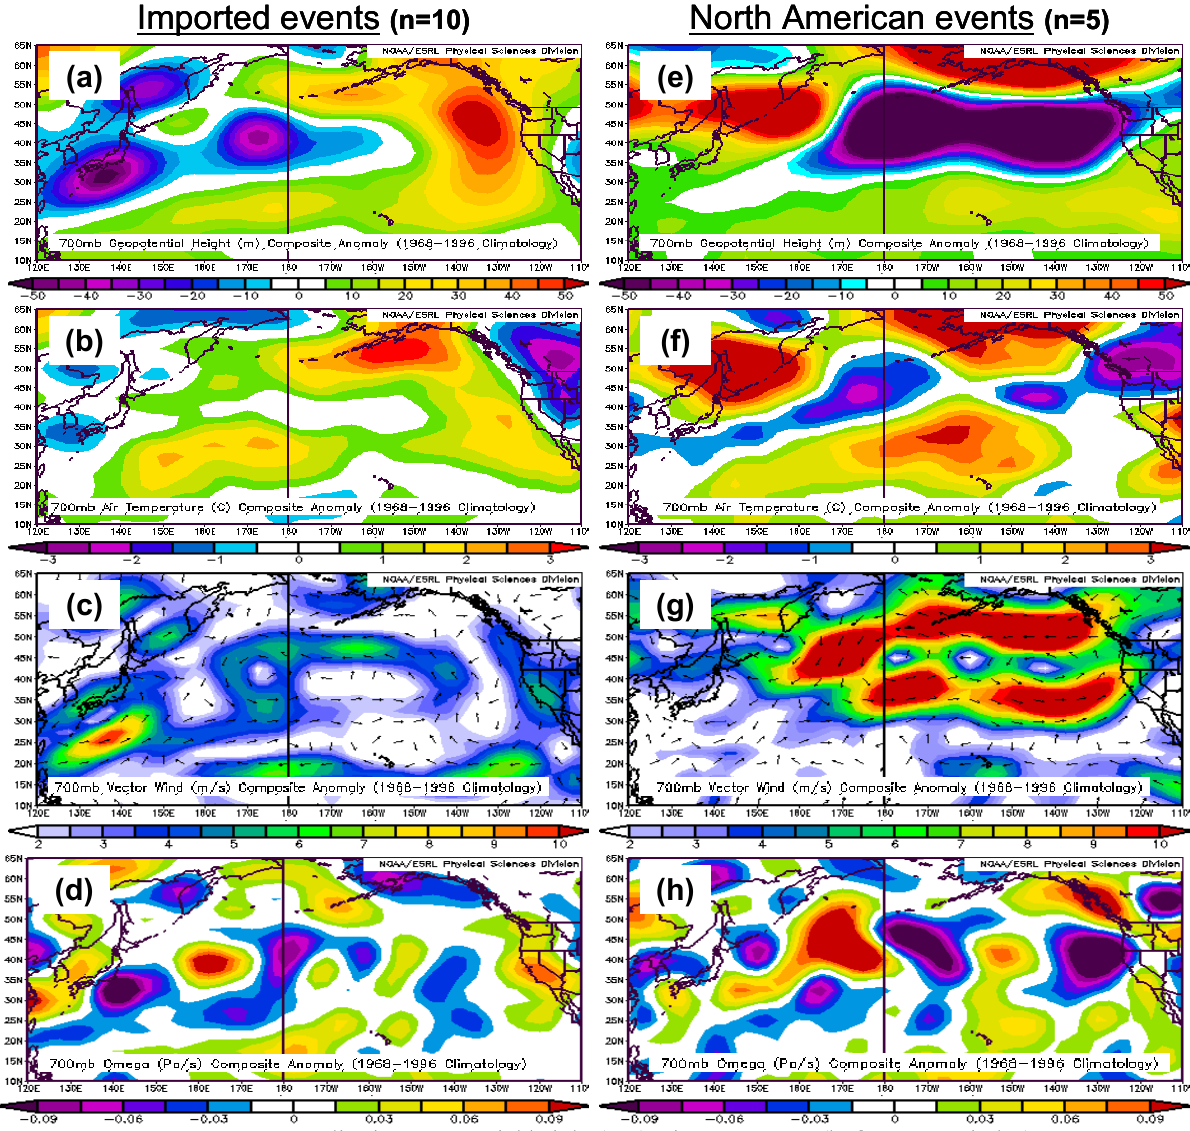
Figure 9. Anomalies in geopotential height (a, e), air temperature (b, f), vector winds (c, g) and vertical velocity (d, h) at 700 hPa (from NCEP reanalysis) for the top 20 clear-sky, FT NO x events at MBO whose backtrajectory analysis allowed a classification of “Imported” (a–d) vs. “North American” (e–h).